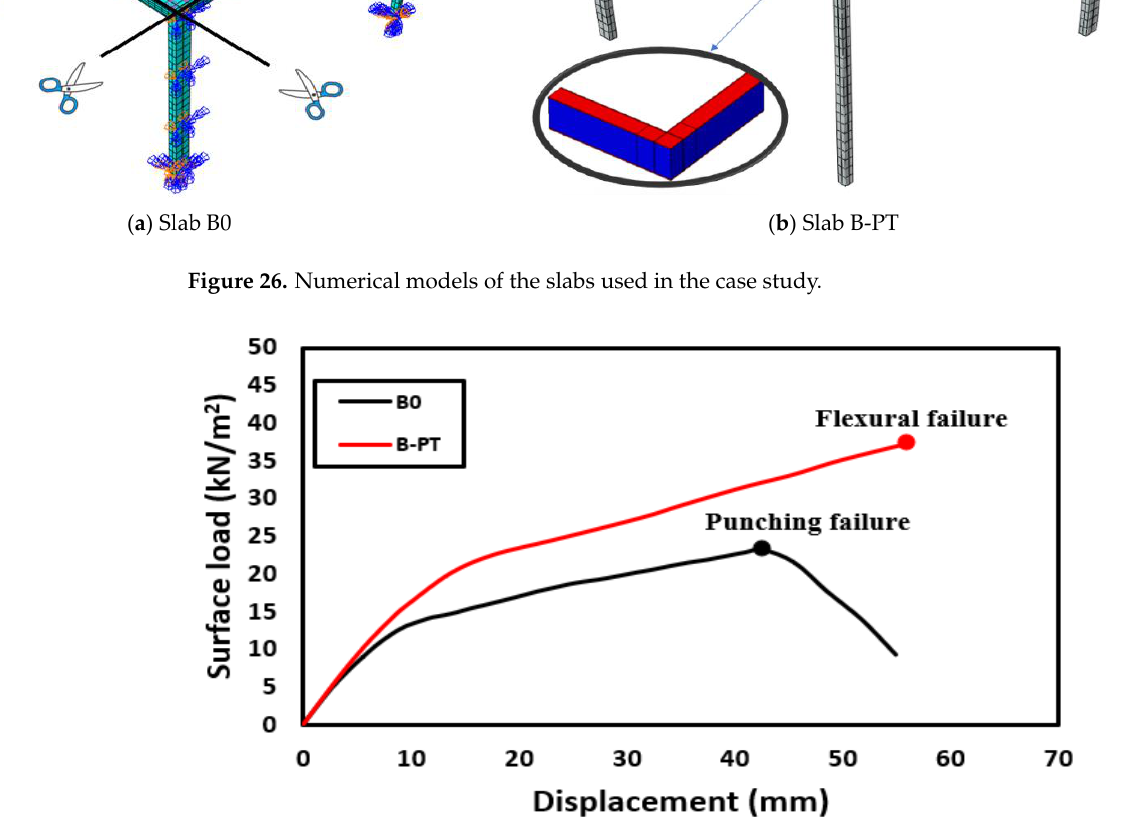
Figure 27. Load – displacement curves for slabs analyzed in the case study.